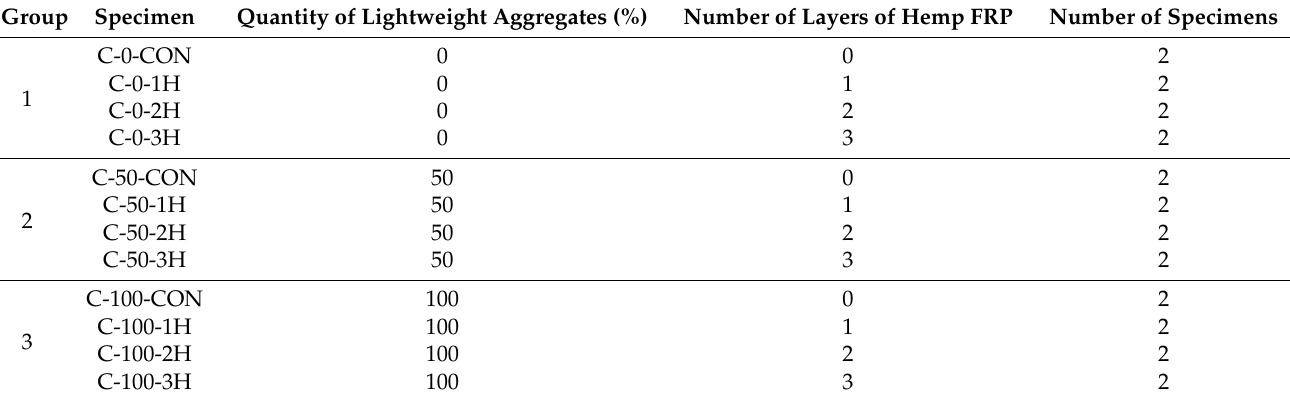
Table 1. Test matrix.